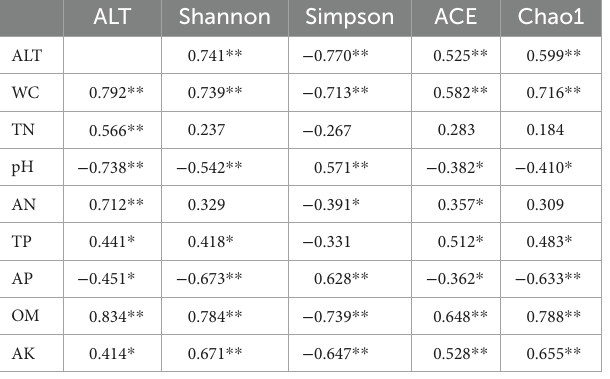
TABLE 4 Person correlation analysis between soil AMF community diversity and soil physicochemical properties.